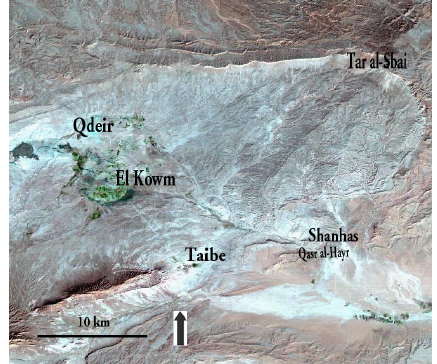
Figure 4. The oasis of El Kowm and Tar al Sbai at the edge of Jebel Bishri. Mapping on Landsat-7 ETM image by M. Lönnqvist 2001.